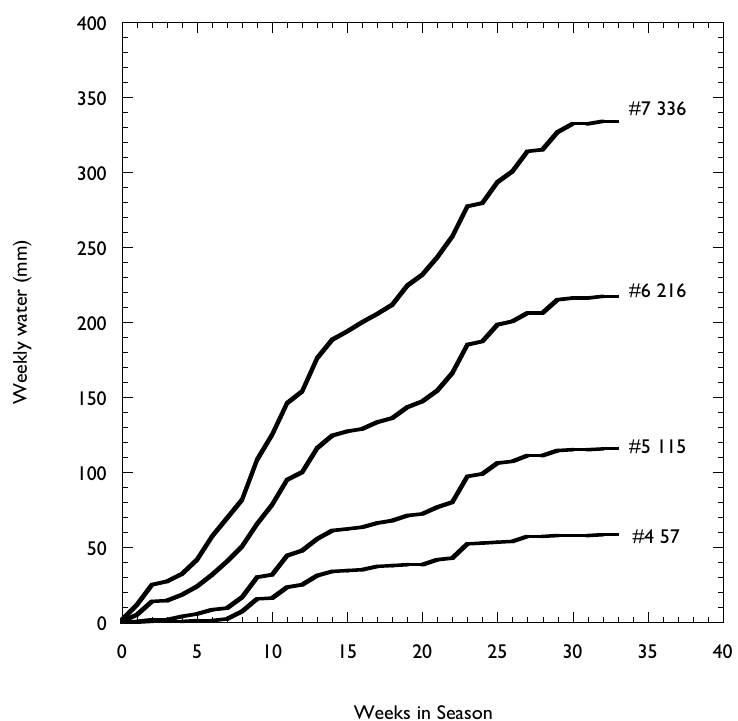
Figure 4. Figure study-rain target sums. The seasonal sums for each of the rain simulations over a 34-week period starting on DOY 90 based on the 4th through 7th decile rain simulation treatments.